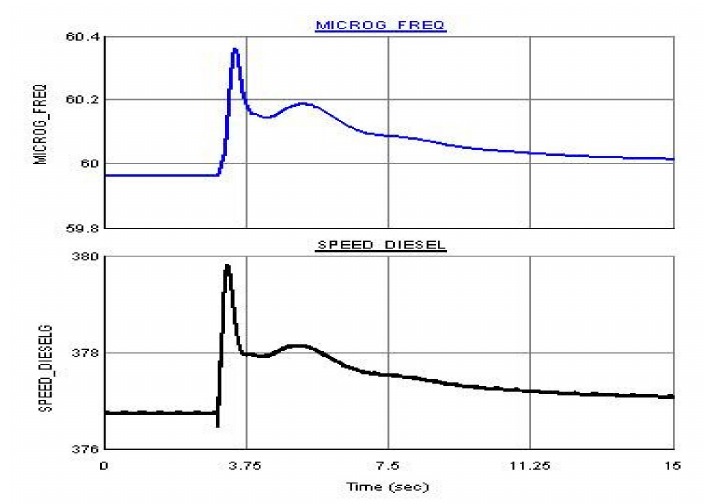
Figure 17. Microgrid frequency and speed of the diesel generator.